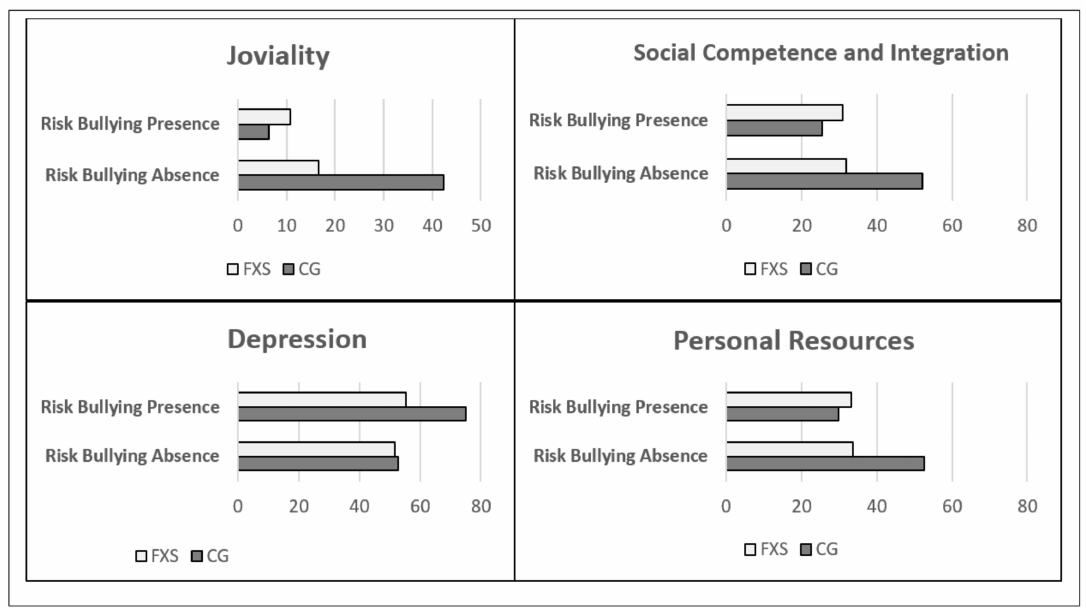
Figure 1. Interaction of “Risk of bullying” with Group on Joviality, Social Competence and Integration, Depression, and Personal Resources. FXS = Fragile X Syndrome. CG = control